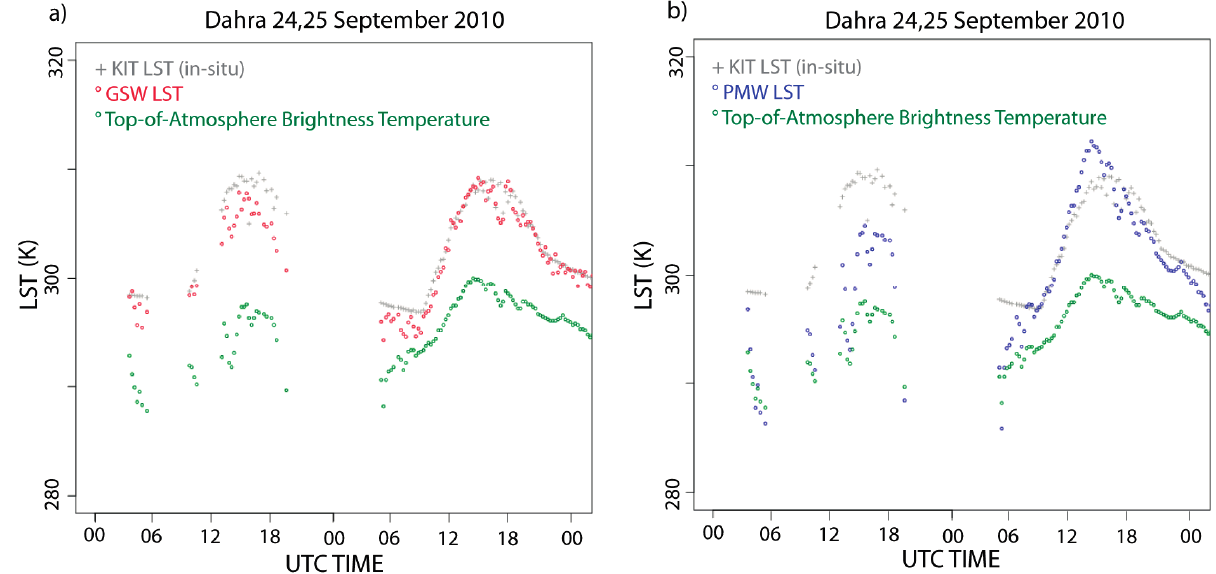
Figure 5. ( a ) LSA SAF’s operational GSW; ( b )